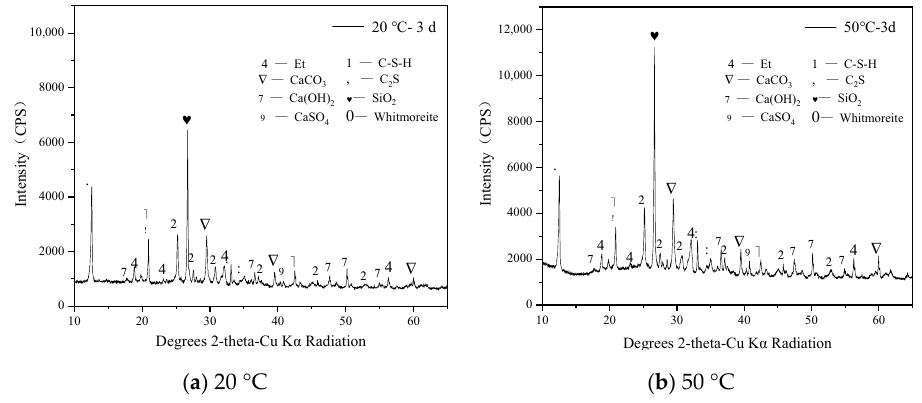
Figure 8. The effect of different curing temperatures on the XRD at 3d. Analysis at 40 ◦ C and 65 ◦ C for 28 d Compared with 40 ◦ C, the strength of CPB decreased at 65 ◦ C at different curing times, and the curing temperature had a significant impact on the strength at 28 d. When the curing temperature is higher than 40 ◦ C, the CPB strength will deteriorate. In order to explain the cause of deterioration, thermal analysis and XRD analysis were performed on the samples at 40 ◦ C and 65 ◦ C for 28 d, as shown in Figure 9. When the curing temperature was 65 ◦ C and the time 28 d, the weight loss and endothermic peak of samples in the temperature ranges of 100–200 ◦ C and 550–700 ◦ C were higher than that at 40 ◦ C, which indicates that more hydrates can be produced at 65 ◦ C and 28 days. 0.000.020.040.060.080.100.120.140.16 40 ℃ - 28 d 65 ℃ - 28 d